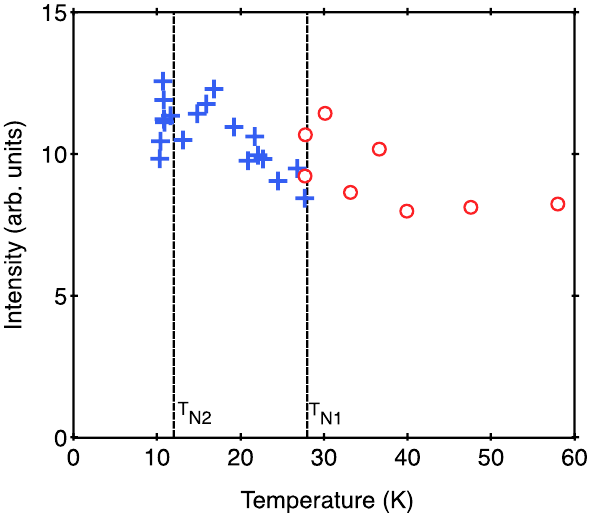
Figure 7. Temperature dependence of the E 1g mode intensity from Raman scattering